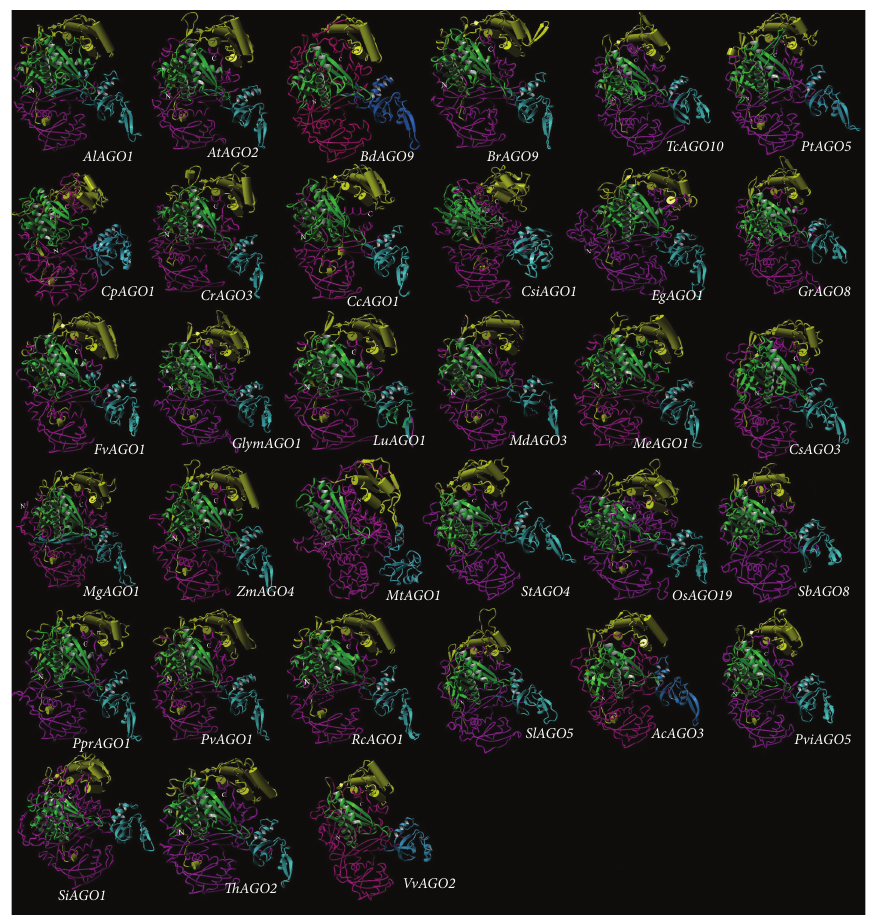
Figure 7: Predicted Argonautes protein fold of AlAGO1 , AtAGO2 , BdAGO9 , BrAGO4 , TcAGO10 , PtAGO5 , CpAGO1 , CrAGO3 , CcAGO1 , CsiAGO1 , EgAGO1 , GrAGO8 , FvAGO1 , GlymAGO1 , LuAGO1 , MdAGO3 , MeAGO1 , CsAGO3 , MgAGO1 , ZmAGO4 , MtAGO1 , StAGO4 , OsAGO19 , PprAGO1 , PvAGO1 , RcAGO1 , SlAGO5 , SbAGO8 , AcAGO3 , SiAGO1 , ThAGO2 , VvAGO2, and PviAGO5